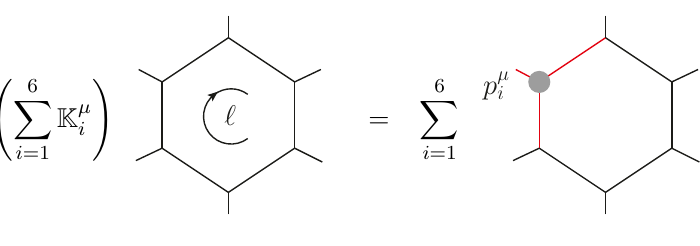
Figure 5 . Conformal Ward identity for the 6D hexagon integral with all legs on